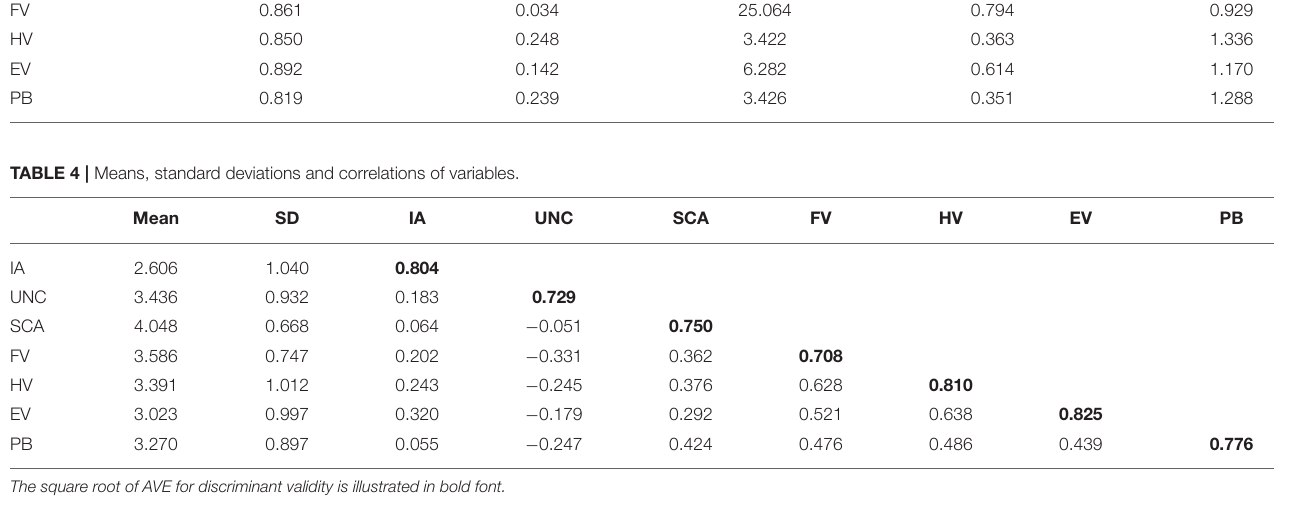
The square root of AVE for discriminant validity is illustrated in bold font.